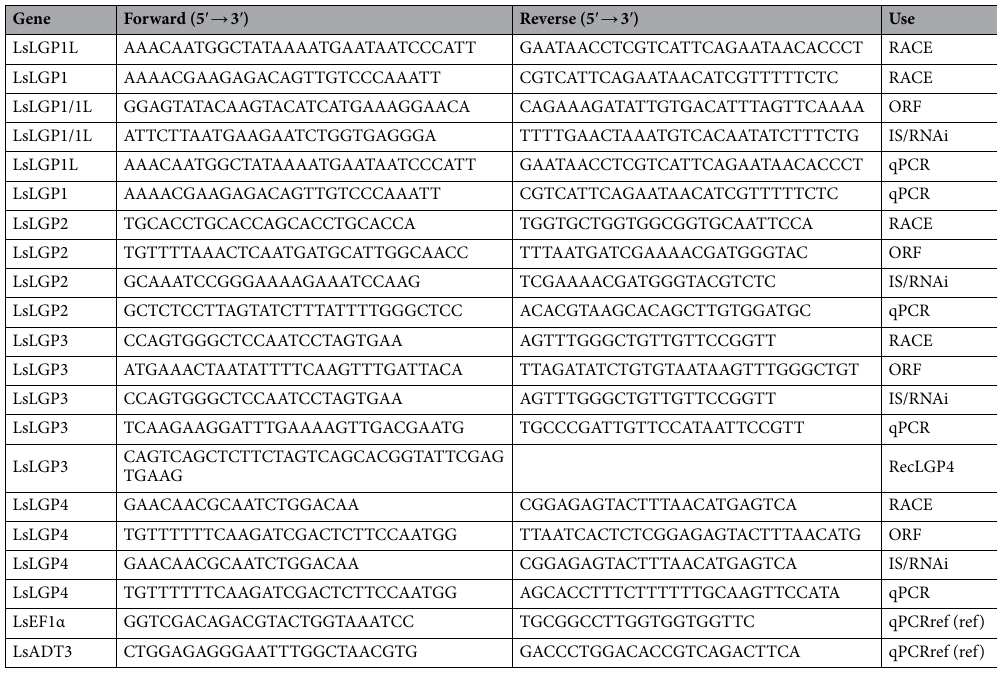
Table 1. Sequences of primers used for characterization of LsLGPs. Primers were used in rapid amplification of cDNA ends (RACE), confirming the open reading frame (ORF), synthesis of RNA probes for in situ hybridization (IS) and double stranded RNA for RNA interference (RNAi), production of recombinant LsLGP3 (recLGP3), and for real time RT-PCR both target genes (qPCR) and reference genes (qPCRref). Gene name abbreviations: Lepeophtheirus salmonis (Ls), labial gland protein (LGP), elongation factor (EF), and adenine nucleotide translocator